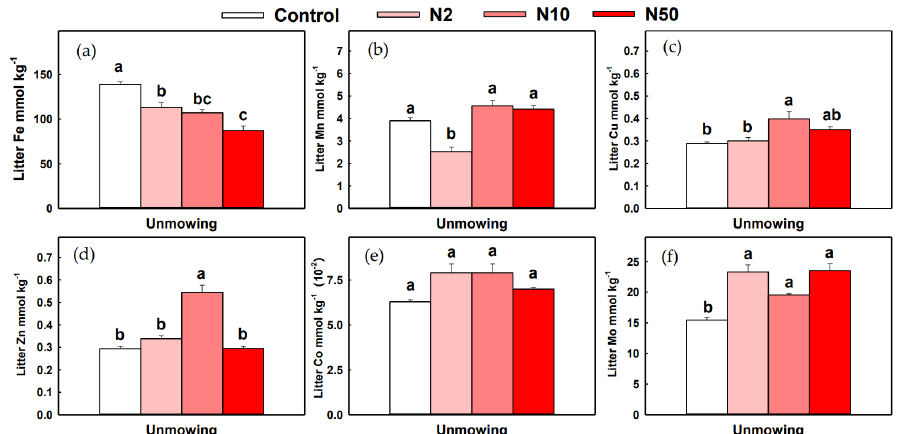
Figure 3. Effects of N addition on the contents of six micronutrients (Fe, Mn, Cu, Zn, Co, and Mo) with unmowing treatments in litter. Notes: Different capital letters denote significant differences ( p < 0.05) between control and N addition plots. (Fe, Mn, Cu, Zn, Co, and Mo ( a ) – ( f )). The content of Co in belowground roots was also affected by N addition, mowing and their interaction, while contents of litter Fe, Mn, Cu and Mo were affected by N addi- tion and its interaction with mowing (Figure 4). Medium and High N addition signifi- cantly decreased root Fe content, whereas medium N addition significantly increased root Mn, Cu and Co contents in both mown and unmown plots (Figure 4). Medium N addition also significantly increased root Zn content in unmown plots (Figure 4d). At the same N addition levels, mowing significantly decreased root Mn content as compared with that in unmown plots, but increased root Co content (Figure 4b,e). Additionally, N addition significantly decreased root Fe pools in unmown plots, whereas N addition, especially under N10 and N50 treatments in both mown and unmown plots, generally increased the pools of root Mn, Cu, Zn, Co and Mo (Figure S4).